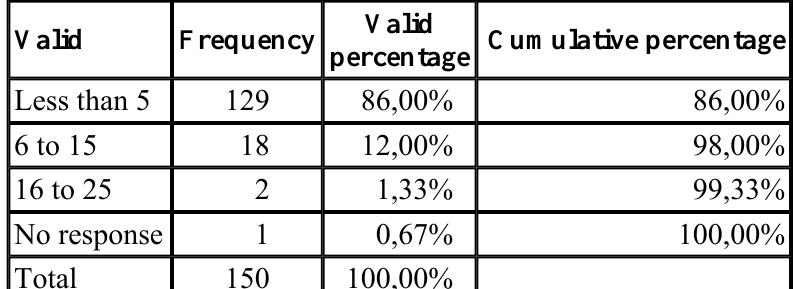
Table 3 Number of pages of non-work-related e-mails printed per